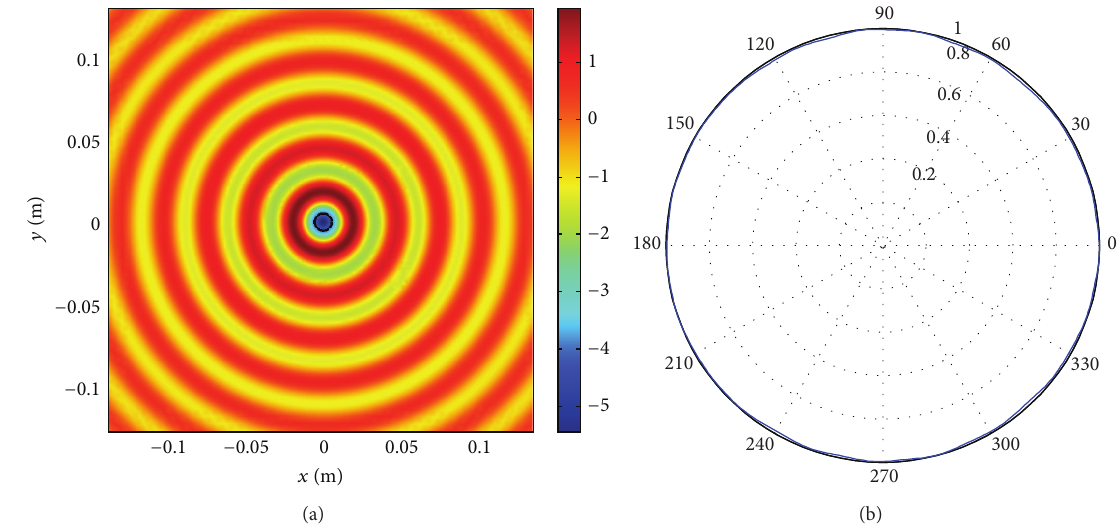
Figure 2: The simulation result of a monopole radiation (color online). (a) The electric field distribution in the 𝑥 - 𝑦 plane. (b) The far-field radiation pattern with a circular